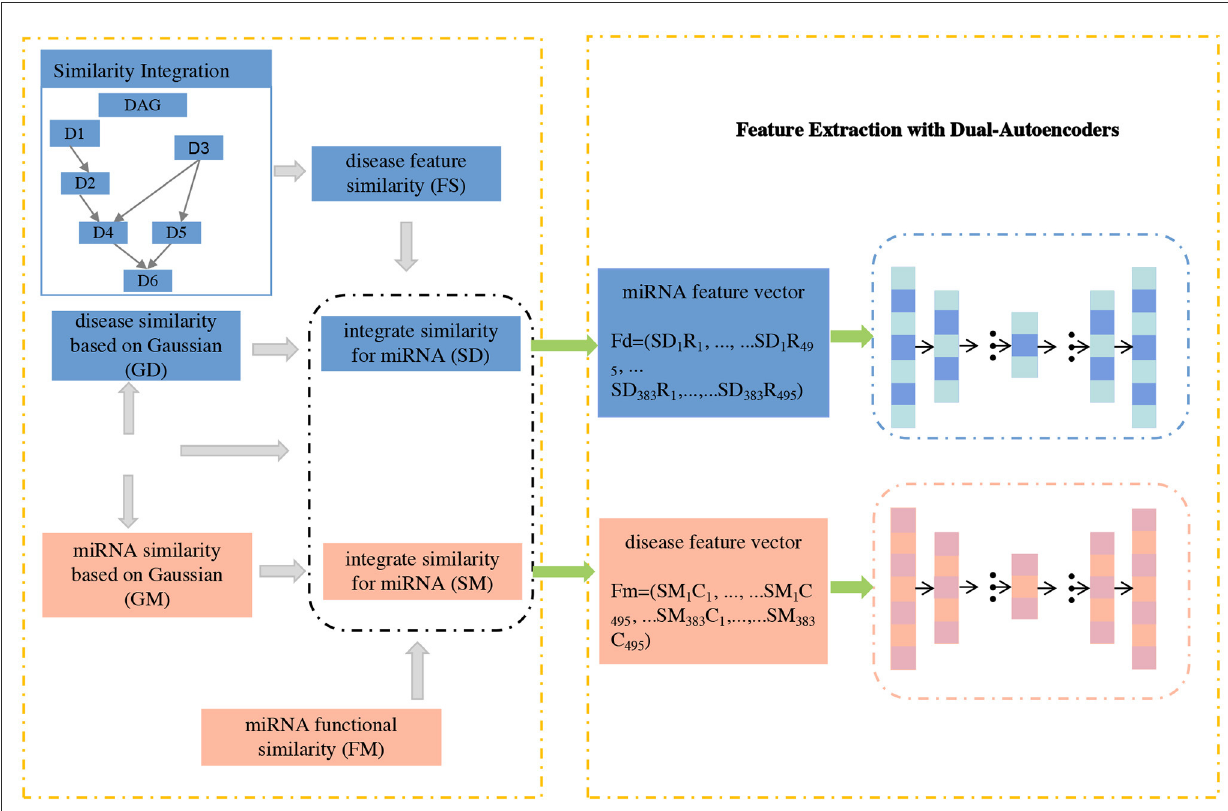
FIGURE1 The concatenated feature representations are input to dual-autoencoders.